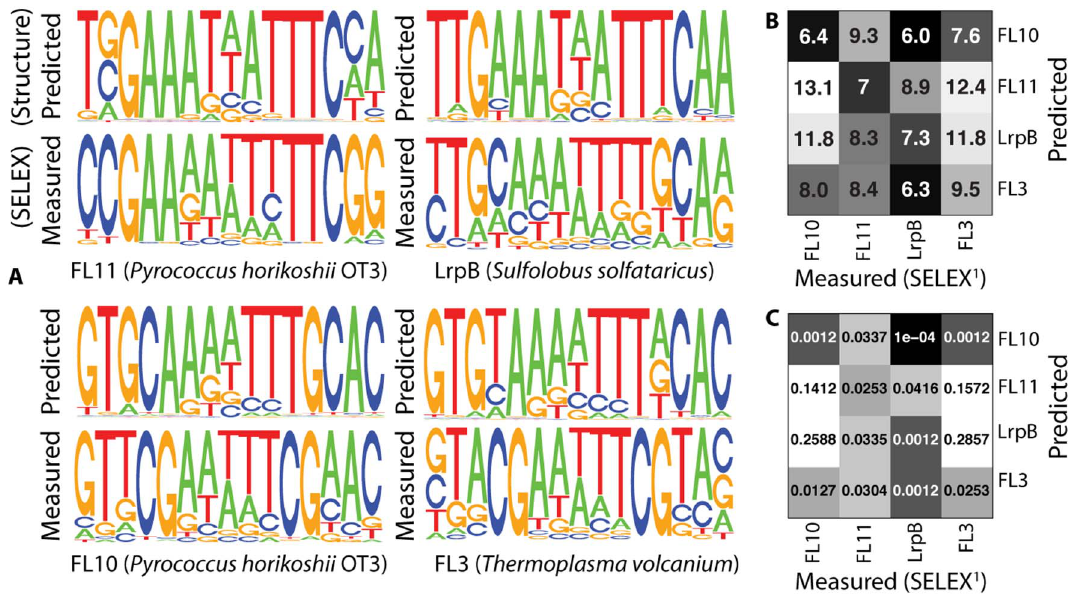
Figure 1. Comparison of predicted FFRP transcription factor DNA-binding specificities with invitro (SELEX) measurements for four FFRPs. A) The predicted DNA-binding preferences of FFRPs FL11 from P. horikoshii (left) and LrpB from S. solfataricus (right) are highly similar to in vitro measurements of the specificities of these transcription factors. B) Euclidian distance matrix for DNA PWMs between each of the predicted and experimentally measured DNA-binding specificities. Dark boxes and low values and indicate higher similarity. C) The significance of similarities between PWMs in the context of comparison between all predicted and measured PWMs (mean reciprocal TOMTOM p -values, adjusted for multiple hypotheses with n =16, Benjamini-Hochberg method).